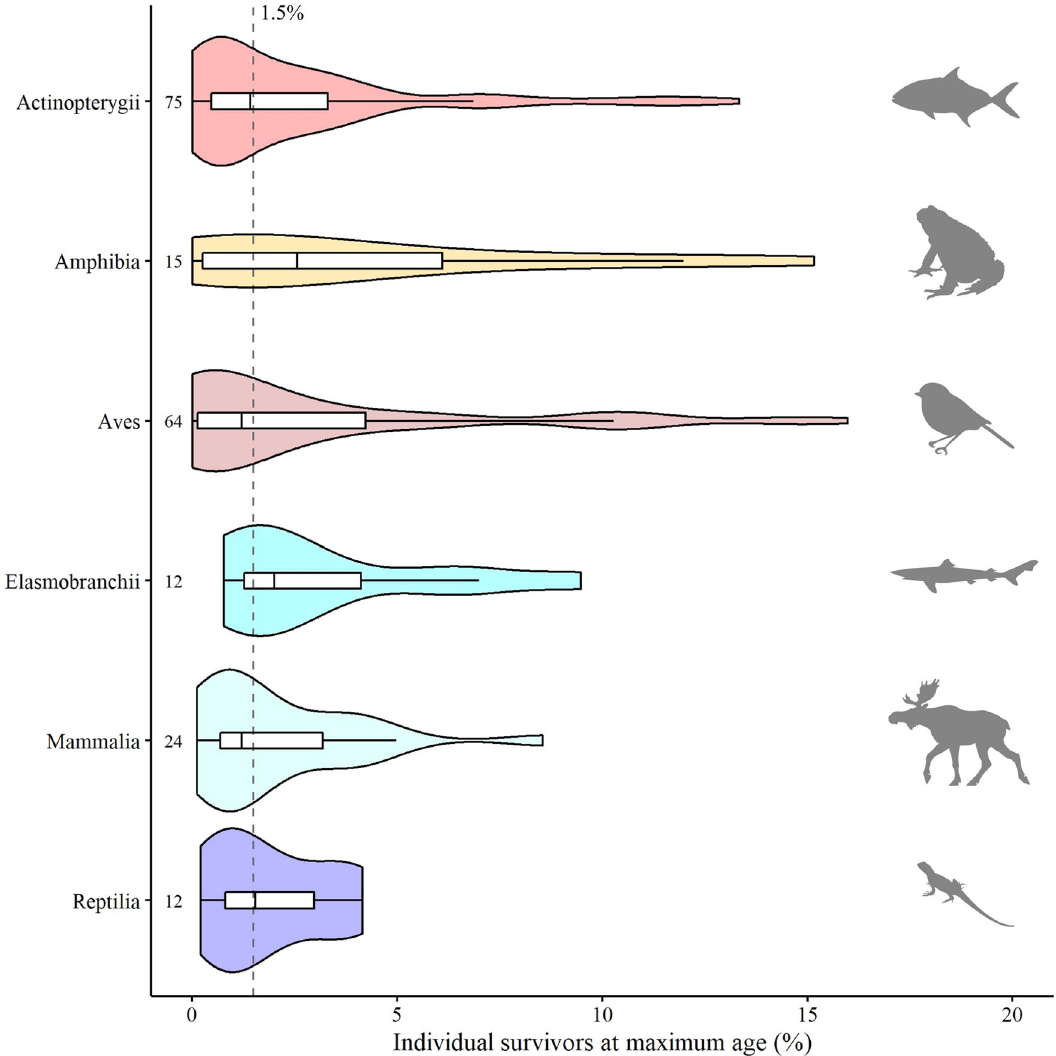
Fig. 1 Survival to maximum age in natural populations of vertebrates. The median survival to average maximum age in a cohort is shown per vertebrate class as a vertical solid line within each boxplot, the 25 th and 75 th percentiles are the lower and upper bound of the boxes, respectively. Violin plots indicate the density distribution of the data points, the numbers refer to the sample size (number of species examined) per vertebrate class. The dashed vertical line indicates the median survivorship to average maximum age in a cohort across all vertebrate classes, at 1.5% survivors. Animal silhouettes represent the different vertebrate classes and are available from PhyloPic (http://www.phylopic.org),